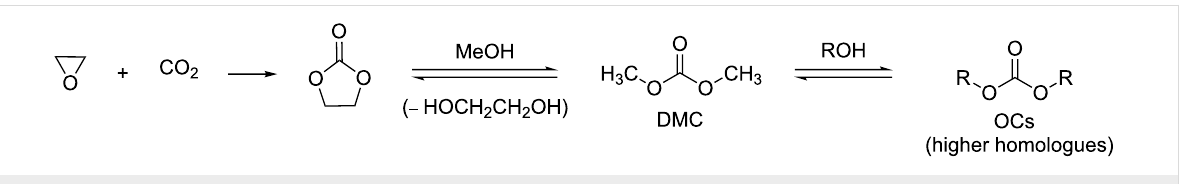
Scheme 7: The transesterification in the synthesis of organic